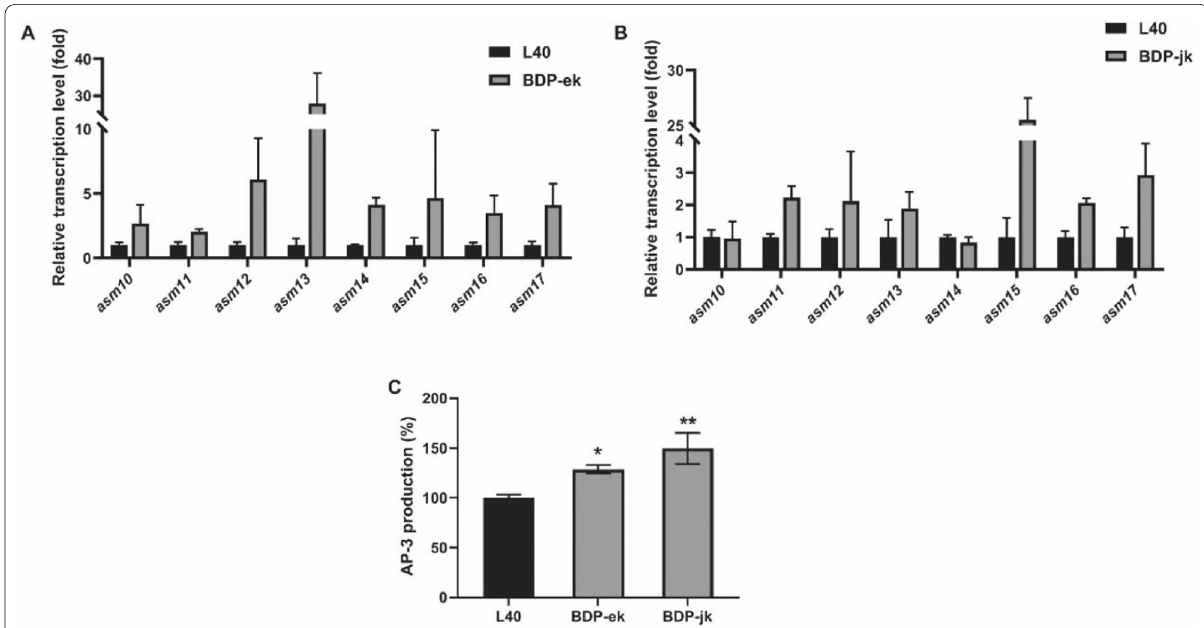
Fig. 10 Transcription levels of AP-3 biosynthetic genes ( A , B ) and AP-3 production of strain L40 and bidirectional promoter knock-in mutant strains ( C ). A , B Transcription pattern of the genes ( asm10 , 11 , 12 , 13 , 14 , 15 , 16 , 17 ) in bidirectional promoter knock-in mutant strains and L40 at day 3 during fermentation process. C Fermentation performance of control strain L40 and bidirectional promoters knock-in strains. Fermentation experiments were performed for three times. The values are means SD of three independent experiments. Significant differences were analyzed by one-way ± ANOVA, and * p < 0.05, ** p <